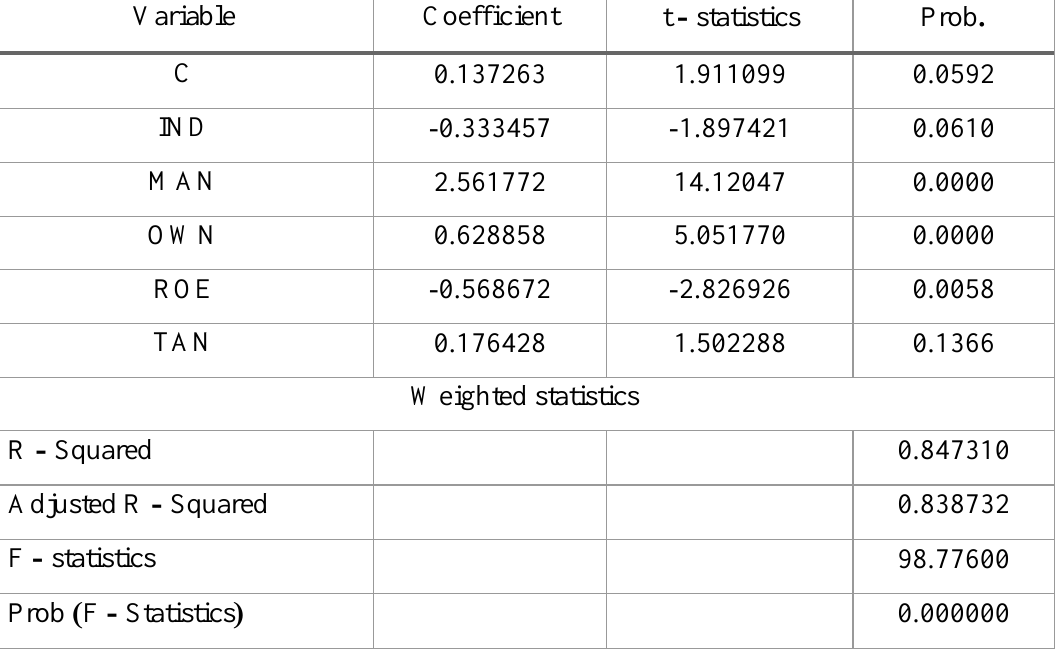
Table 05 – GLS test for Manufacturing